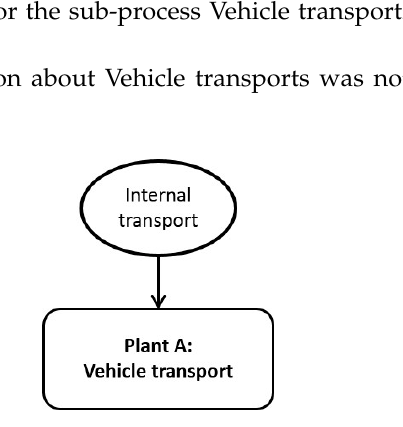
Figure 8. The connection between the sub-process vehicle transports and unit processes at biogas plant A.